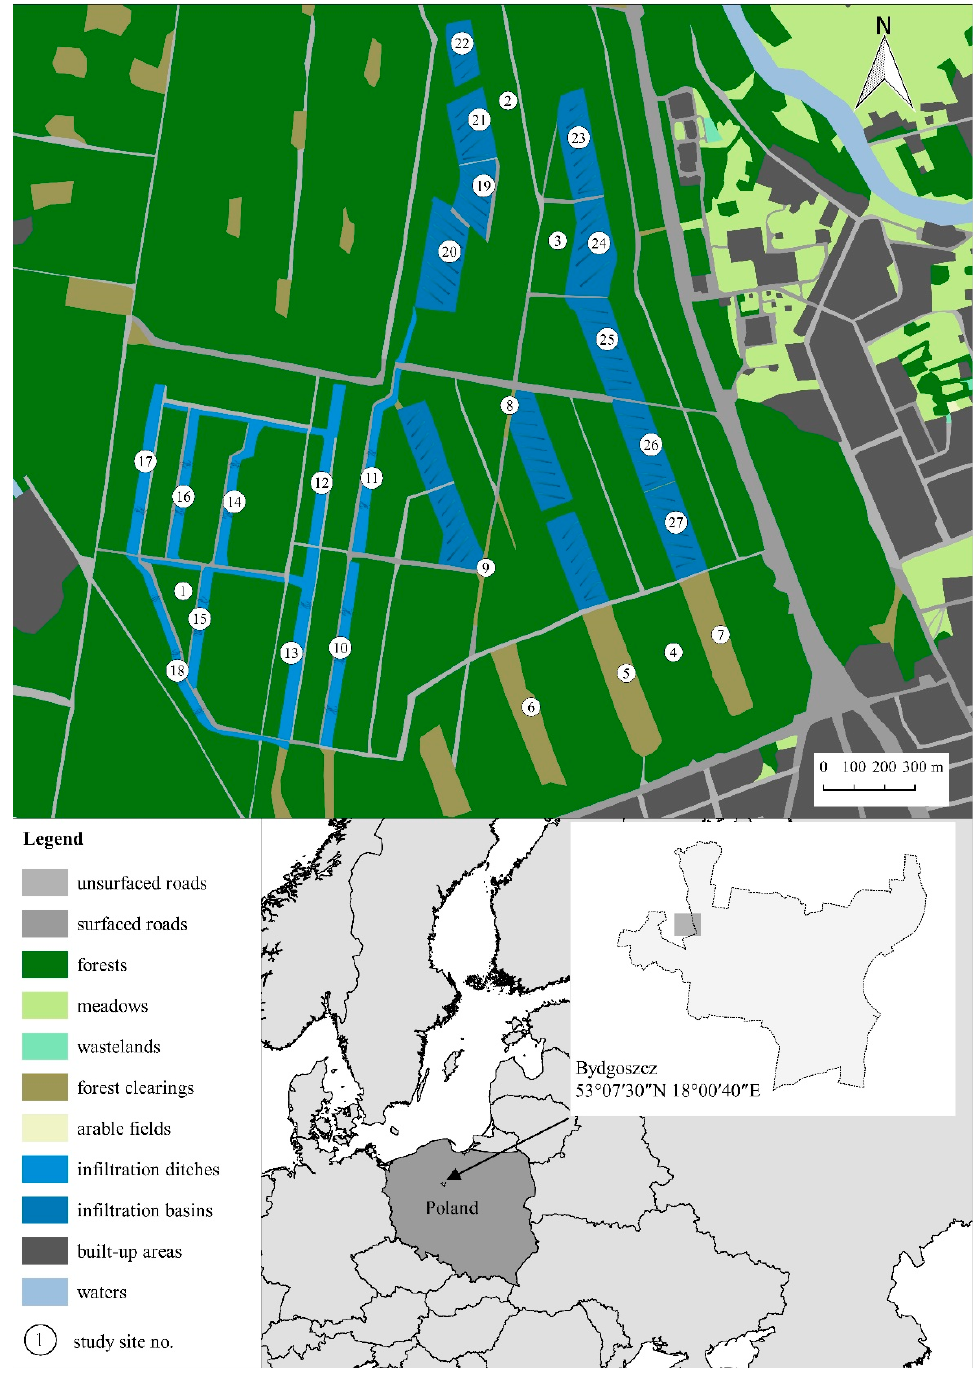
Figure 1. Location of sampling sites: forests (1–4), clearings (5–9), infiltration ditches (10–18), and infiltration basins (19–27).